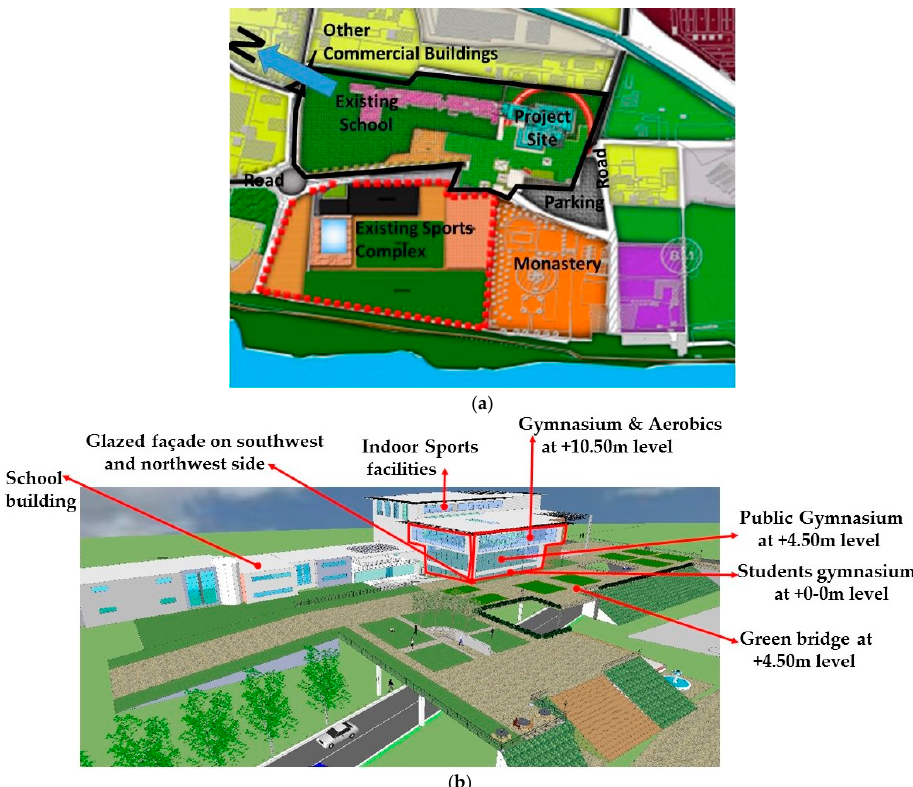
Figure 1. ( a ) Master plan of site; ( b ) 3D view of site.